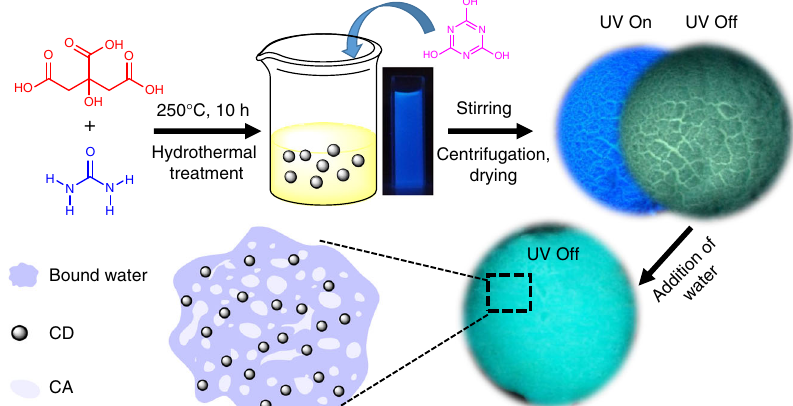
Fig. 1 Preparation of the CDs and the CD-CA system. Schematic illustration for the preparation of the CDs and the CD-CA